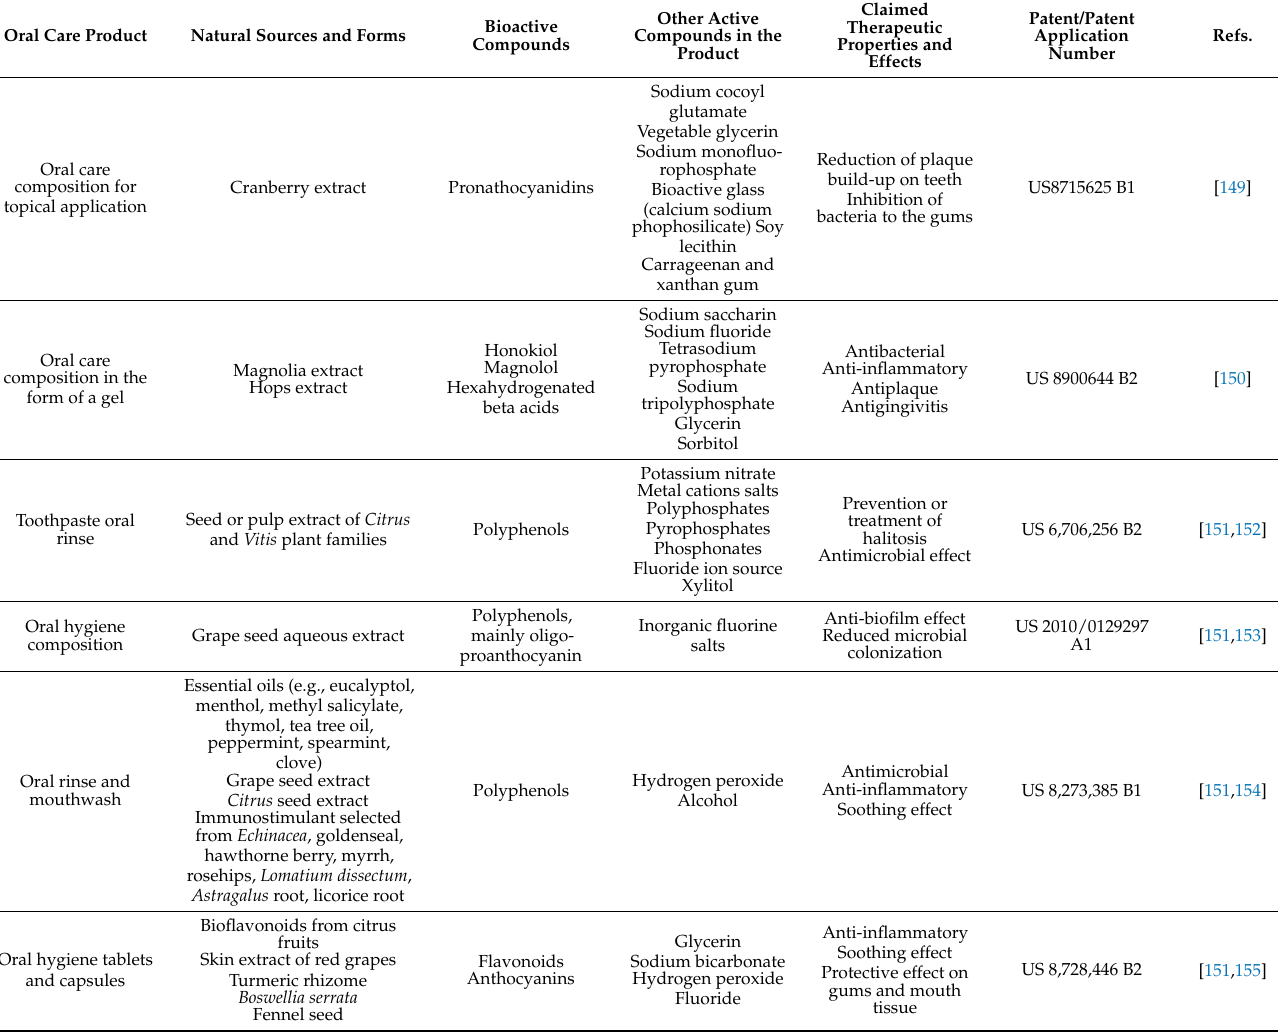
Table 4. Examples of patented applications of oral care products based on natural